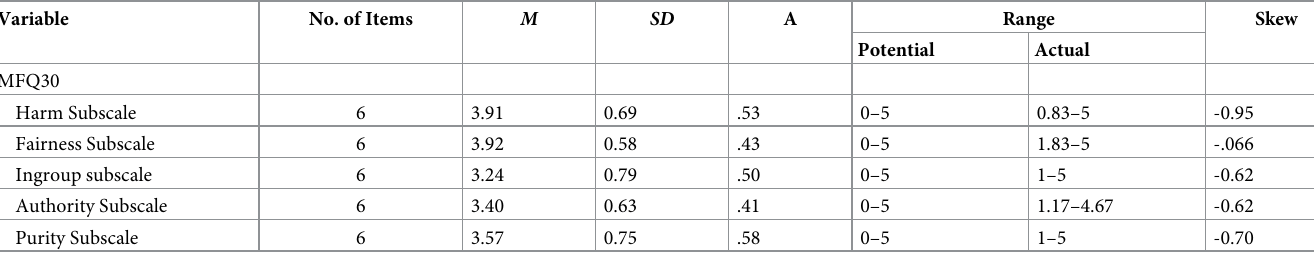
Table 1. Descriptive statistics and alpha coefficients of each subscale (N = 300).